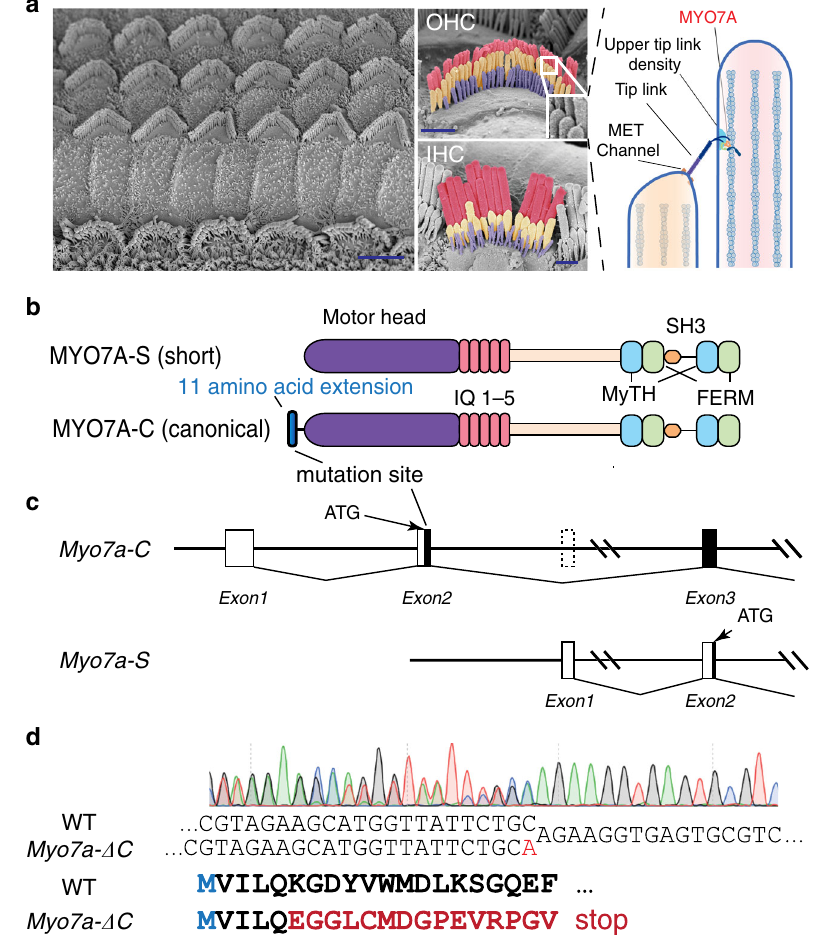
Fig. 1 Speci fi c deletion of the canonical MYO7A-C isoform. a Scanning electron micrographs depicting IHCs and OHCs in the mouse organ of Corti, and a schematic illustration of the proposed function of MYO7A at the upper tip-link density of the mechanotransduction complex (scale bars: 5 μ m in overview SEM, and 1 μ m in OHC and IHC SEMs). b , c Graphical illustration of the canonical and the presumed short MYO7A protein isoforms (MYO7A-C and MYO7A-S, respectively) and corresponding genomic structures. The site of the deleterious mutation in the Myo7a- Δ C mouse is indicated. d Sanger sequencing result of the heterozygous Myo7a- Δ C founder mouse. An adenine insertion (shown in red) introduces a deleterious mutation in the reading frame of Myo7a-C . Sequencing was performed from the reverse